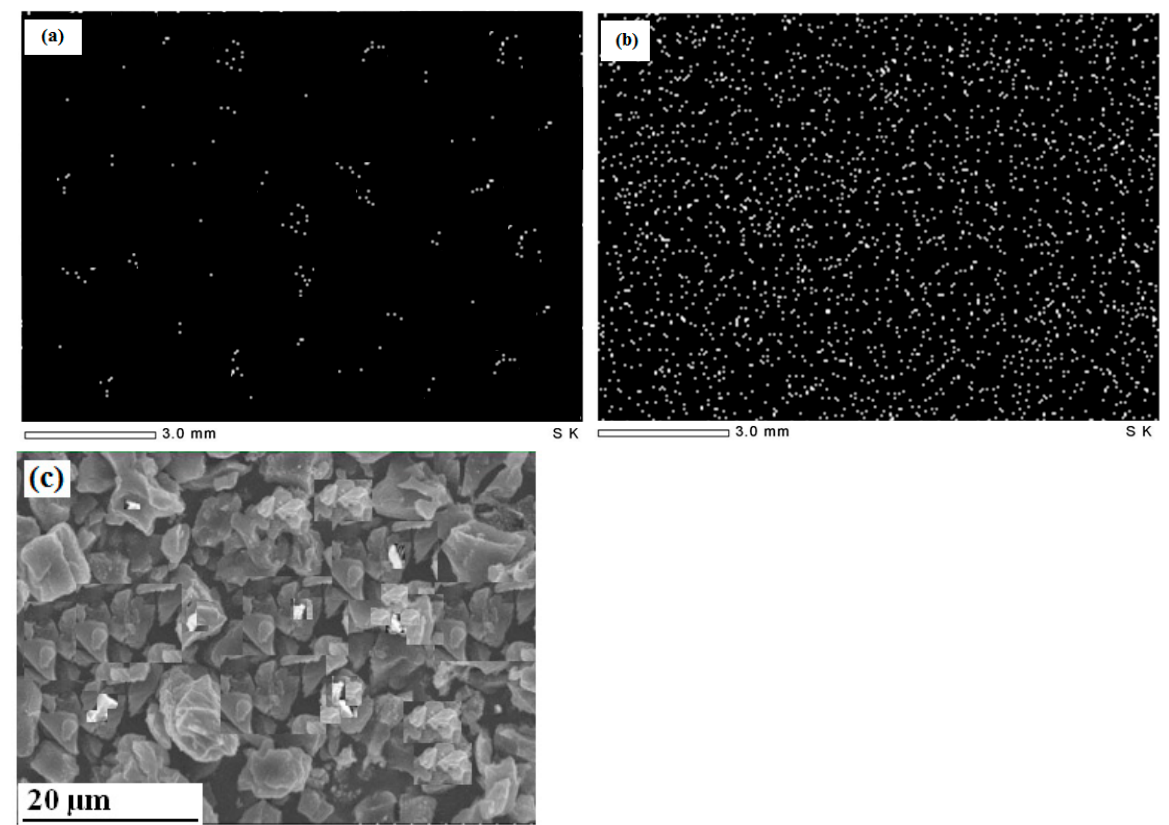
Figure 2. Elemental mapping for cations in: ( a ) fresh adsorbent, ( b ) adsorbent, and ( c ) SEM image of fresh adsorbent.